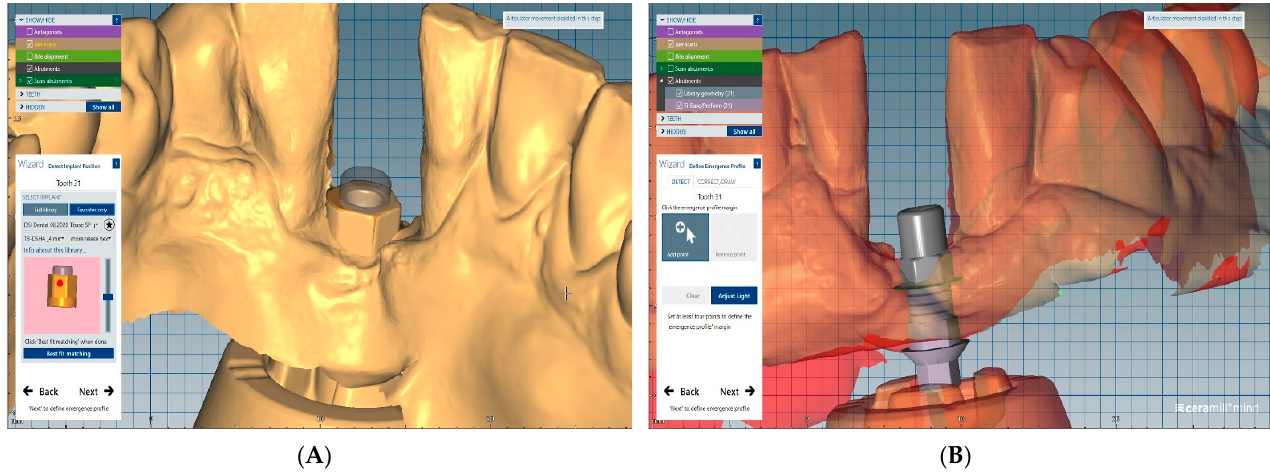
Figure 7. Ti base: ( A ) Ti base loading; ( B ) Ti base superimposed.